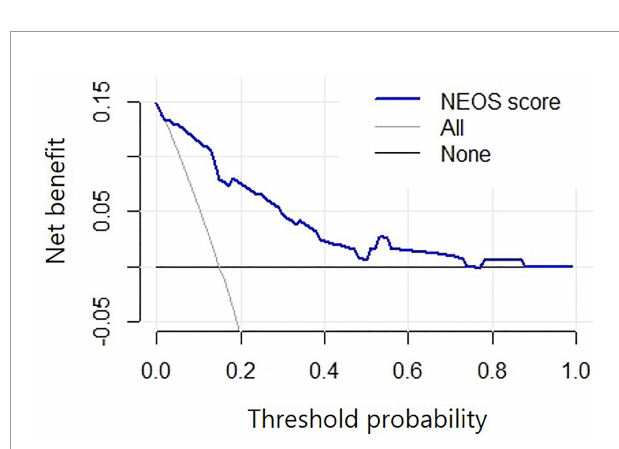
FIGURE 2 | Receiver operating characteristic curve for the prediction of the one-year outcome using the NEOS score. The area under the curve is 0.870 (95% CI: 0.801-0.938, P < 0.001).